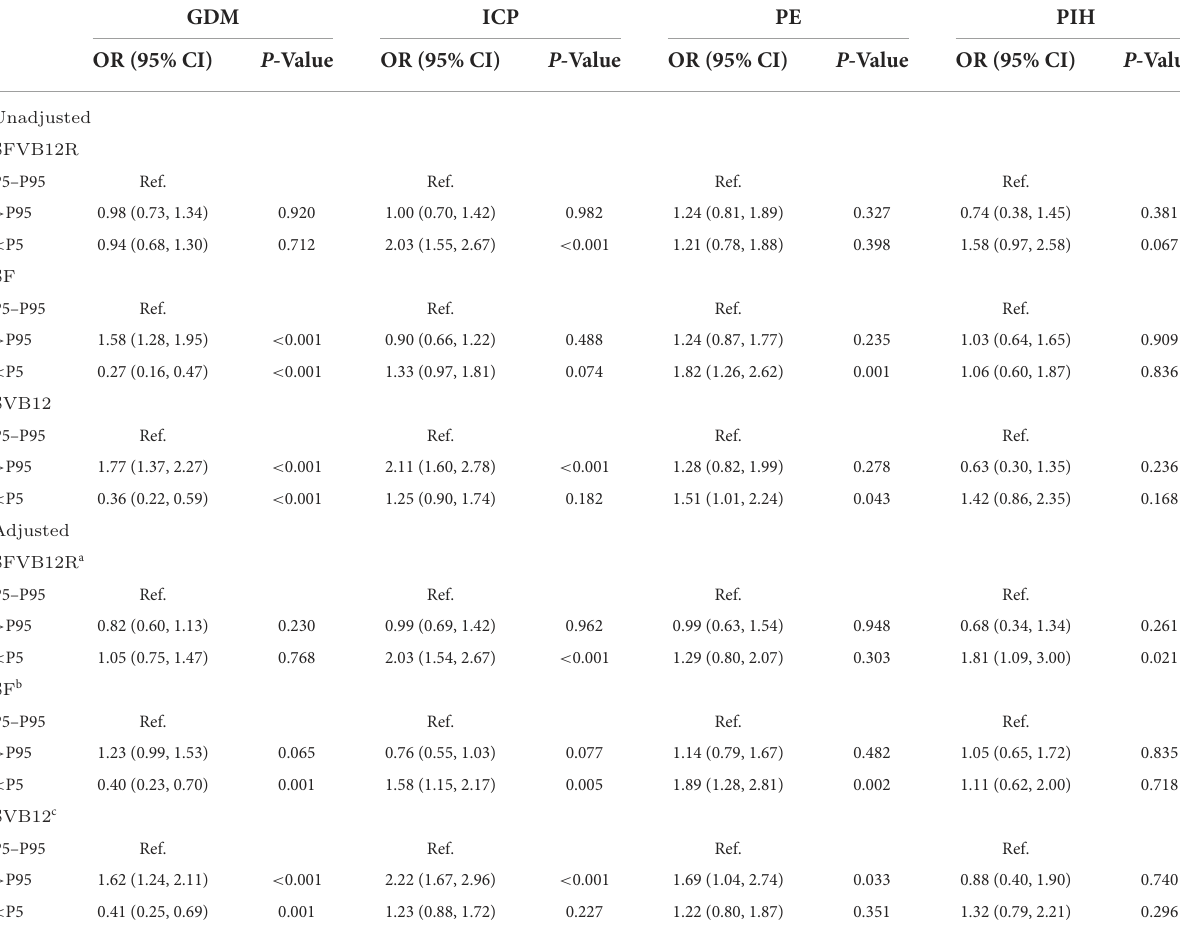
TABLE 6 ORs and 95% CIs for different pregnancy complications with categories of maternal SF, SVB12 levels, and their